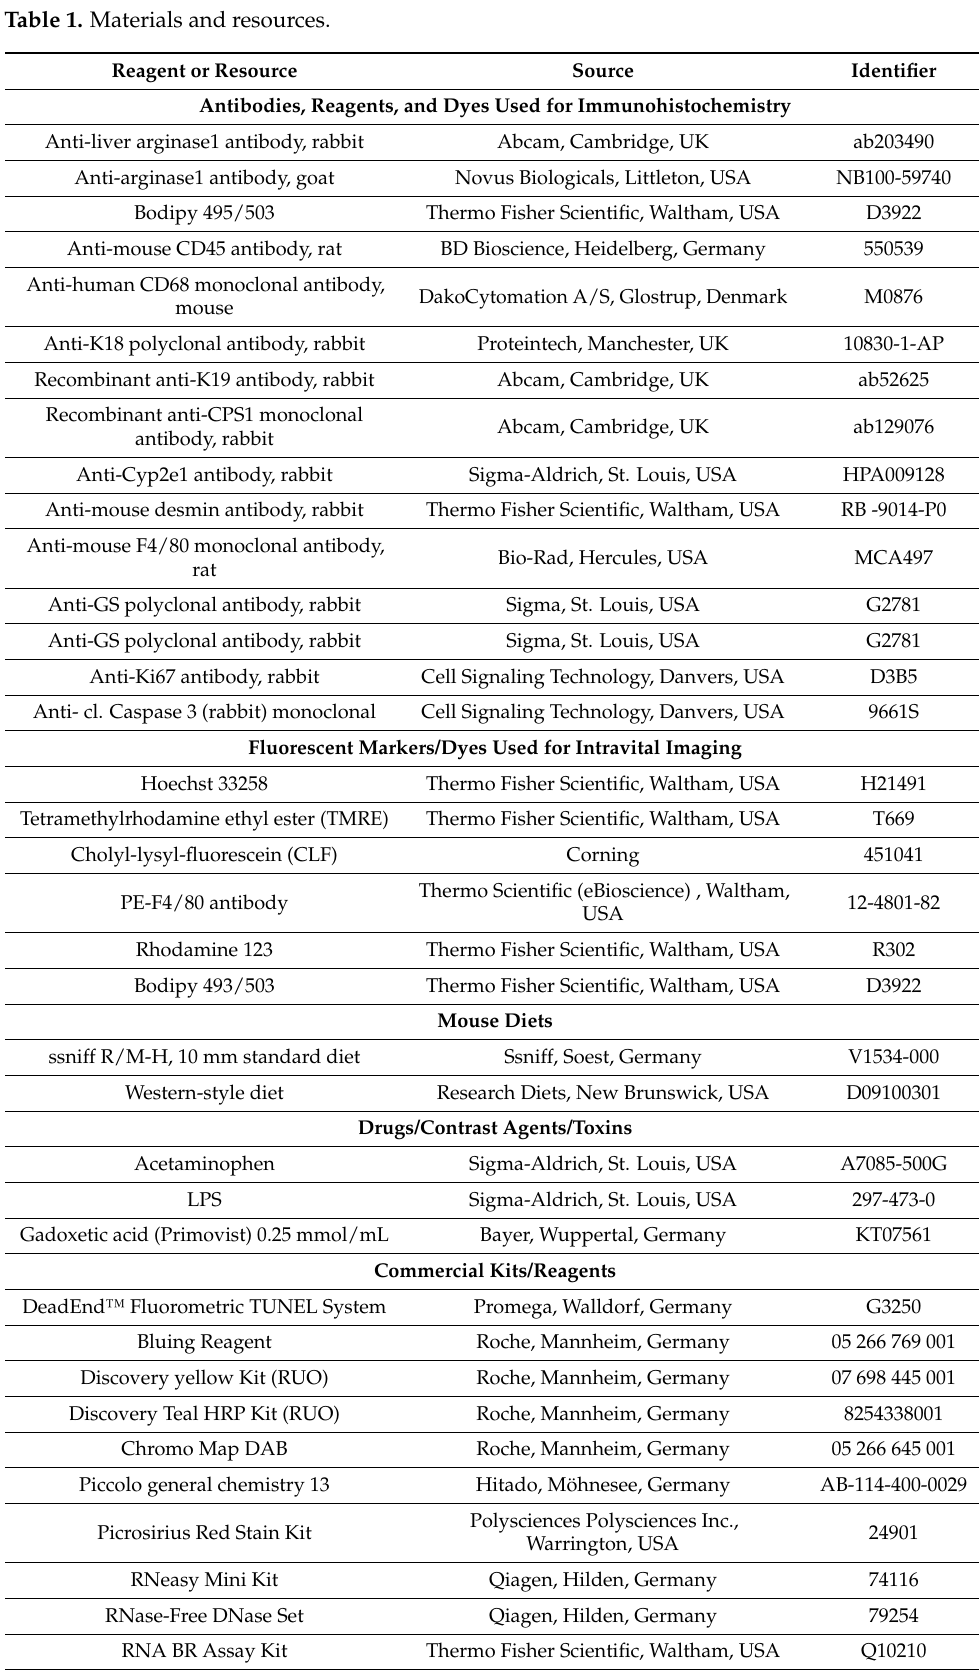
Table 1. Materials and